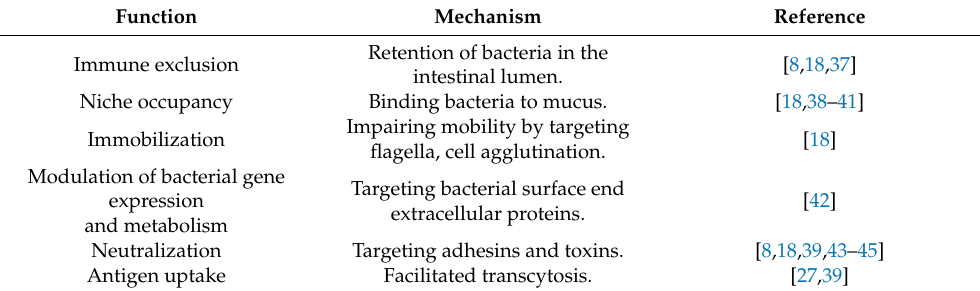
Table 1. The primary functions of SIgA in gut mucosal